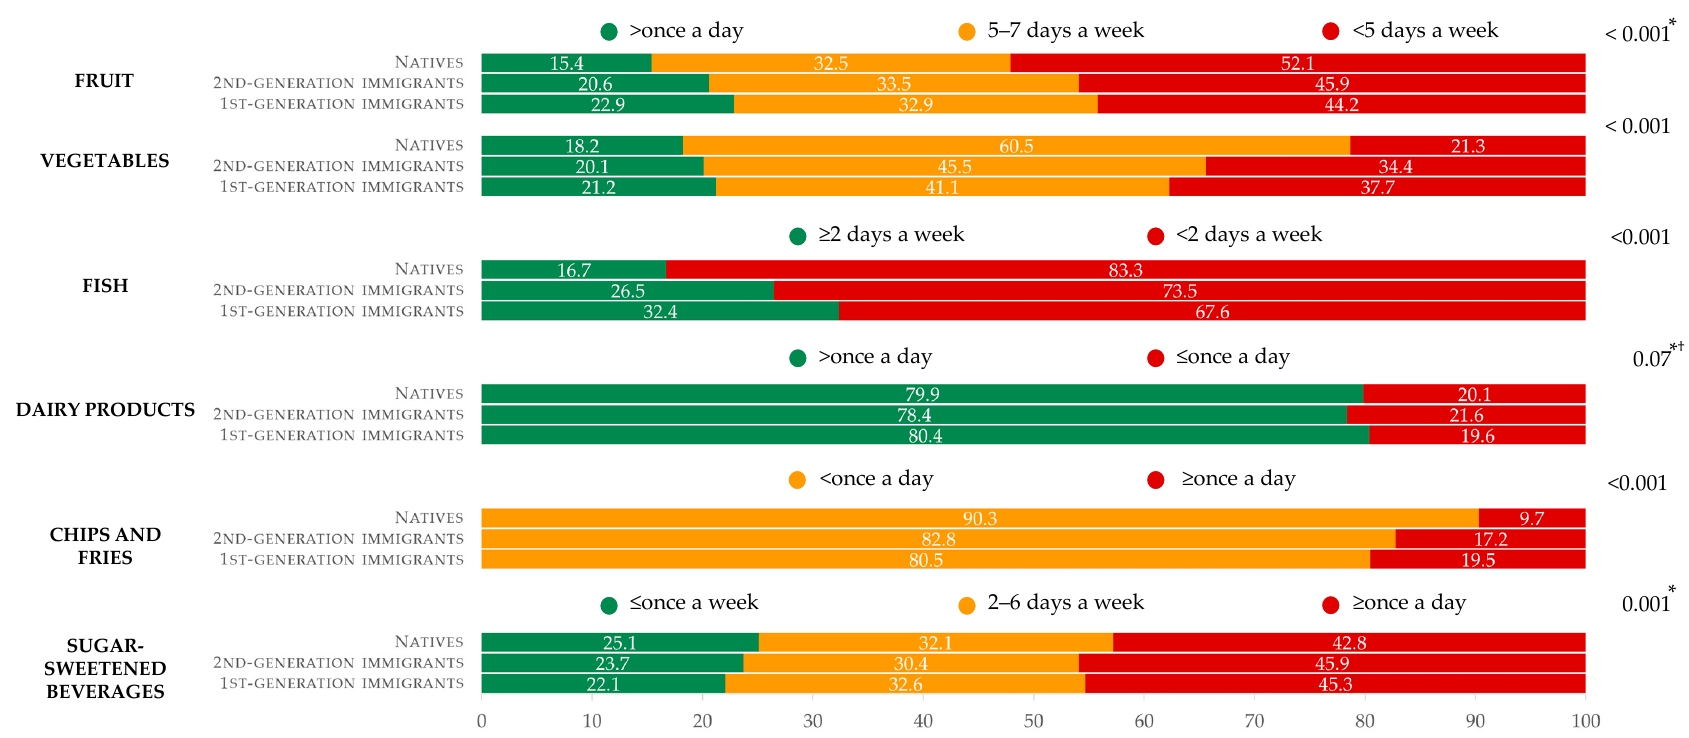
Figure 2. Distribution of food consumption frequencies by migration status in the sample, HBSC, Belgium, 2014. Favorable, moderately favorable, and unfavorable behaviors are represented, respectively, in green, orange, and red. * Nonsignificant difference between 2nd- and 1st-generation immigrants, † nonsignificant difference between natives and 1st-generation immigrants.